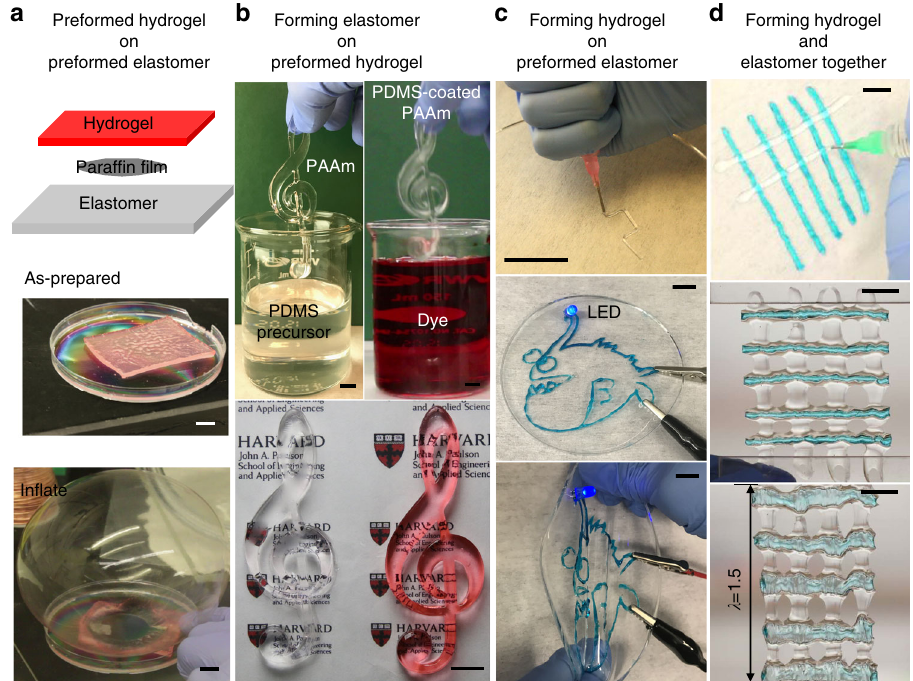
Fig. 7 Manufacturing processes that involve various sequences of forming networks. a A preformed hydrogel network on a preformed elastomer network. A PAAm hydrogel and a PDMS elastomer are separately molded, and then placed in contact with a thin fi lm of paraf fi n sandwiched in between. After curing, the contact region between the hydrogel and the elastomer forms bonds while the paraf fi n region does not. The bonding remains intact as a nozzle in fl ates the hydrogel into a balloon. b Forming an elastomer network on a preformed hydrogel network. A PAAm G-clef is molded, and then dip-coated with a thin layer of PDMS. The PDMS-coated PAAm is dyed in a bath. The color is readily washed away in clean water. By comparison, if a naked hydrogel is dyed in the bath, the color cannot be washed away. c Forming a hydrogel network on a preformed elastomer network. A PDMS fi lm is cast fi rst. On the PDMS fi lm, a hydrogel ionic circuit with the shape of an angler fi sh is written using a syringe. A light-emitting diode (LED) is switched on. The circuit remains adherent when the elastomer is stretched. d Forming a hydrogel network and an elastomer network together. A silane-modi fi ed PAAm hydrogel resin is colored with a blue dye and extruded on a Petri dish. Partially cured PDMS resin is then extruded into lines perpendicular to the hydrogel lines. After curing, the mesh withstands stretching. The scale bars represent 10